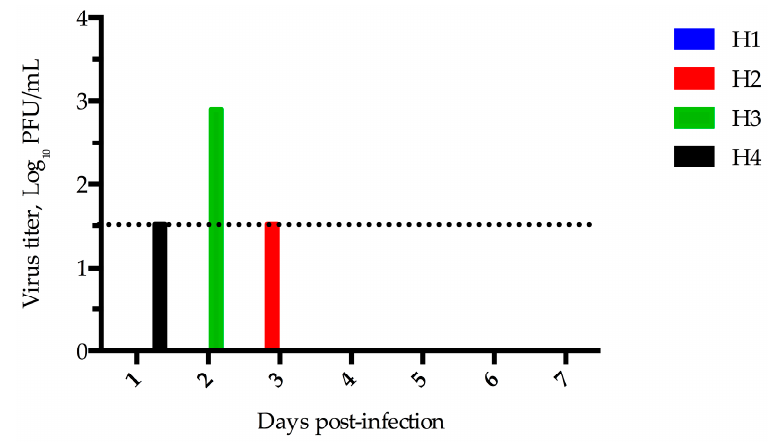
Figure 4. MERS-CoV Shedding in Horses. Virus isolation was performed by plaque assay from nasal swab specimens obtained from horses experimentally infected with MERS-CoV. The limit of detection for this assay is 1.5 log 10 PFU/mL, indicated by the dashed line.